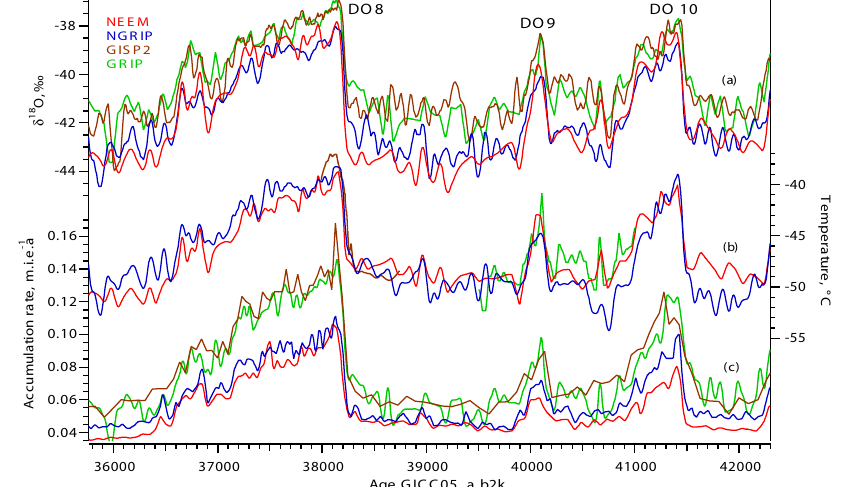
Fig. 4. NEEM (red), NGRIP (blue), GISP2 (brown) and GRIP (green) comparison. (a) Water isotopes, 50yr running average, ‰ vs. VS- MOW. NEEM: this study. NGRIP: NGRIP members (2004). GISP2: Grootes et al. (1993). GRIP: Johnsen et al. (1992). (b)